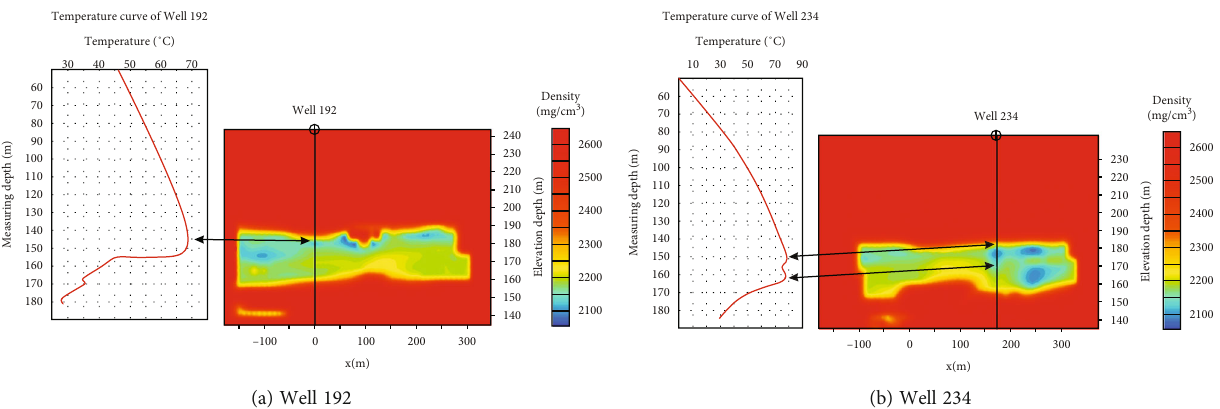
Figure 8: Comparison of temperature curve and inversion density pro fi le of wells 192 and 234.